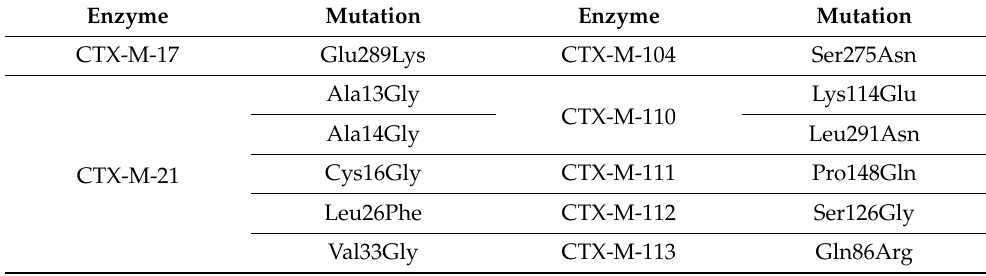
Table 3. Enzymes from CTX-M-9 cluster enzymes and their respective exclusive